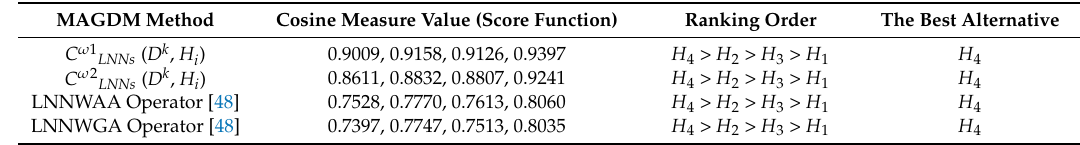
Table 1. Decision results based on LNN MAGDM